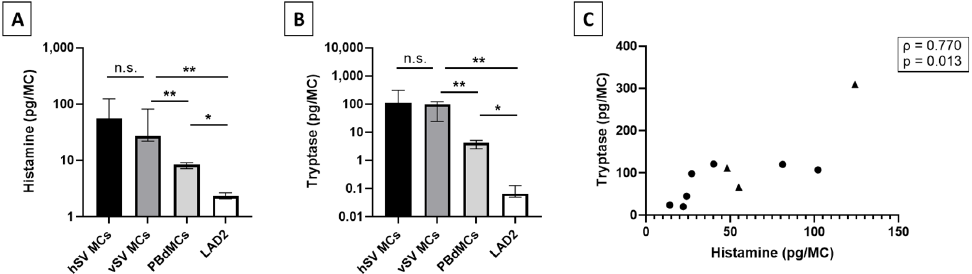
Figure 2. Histamine and tryptase content in mast cells (MCs) from vein or in vitro cultures. MCs from healthy saphenous vein (hSV MCs, n = 3), from varicose saphenous vein (vSV MCs, n = 7), PBdMCs ( n = 4), and LAD2 ( n = 4) were lysed by repeated cycles of freeze-thawing and mechanical disruption. The lysed solutions were used to measure the pg/MC of histamine ( A ) and tryptase ( B ). ( C ): Correlation of histamine and tryptase in MCs from hSV (triangle, n = 3) and vSV (circles, n = 7) saphenous vein was plotted and correlation tested using Spearman correlation. * p < 0.05, ** p < 0.01, n.s.: non-significant p -value.